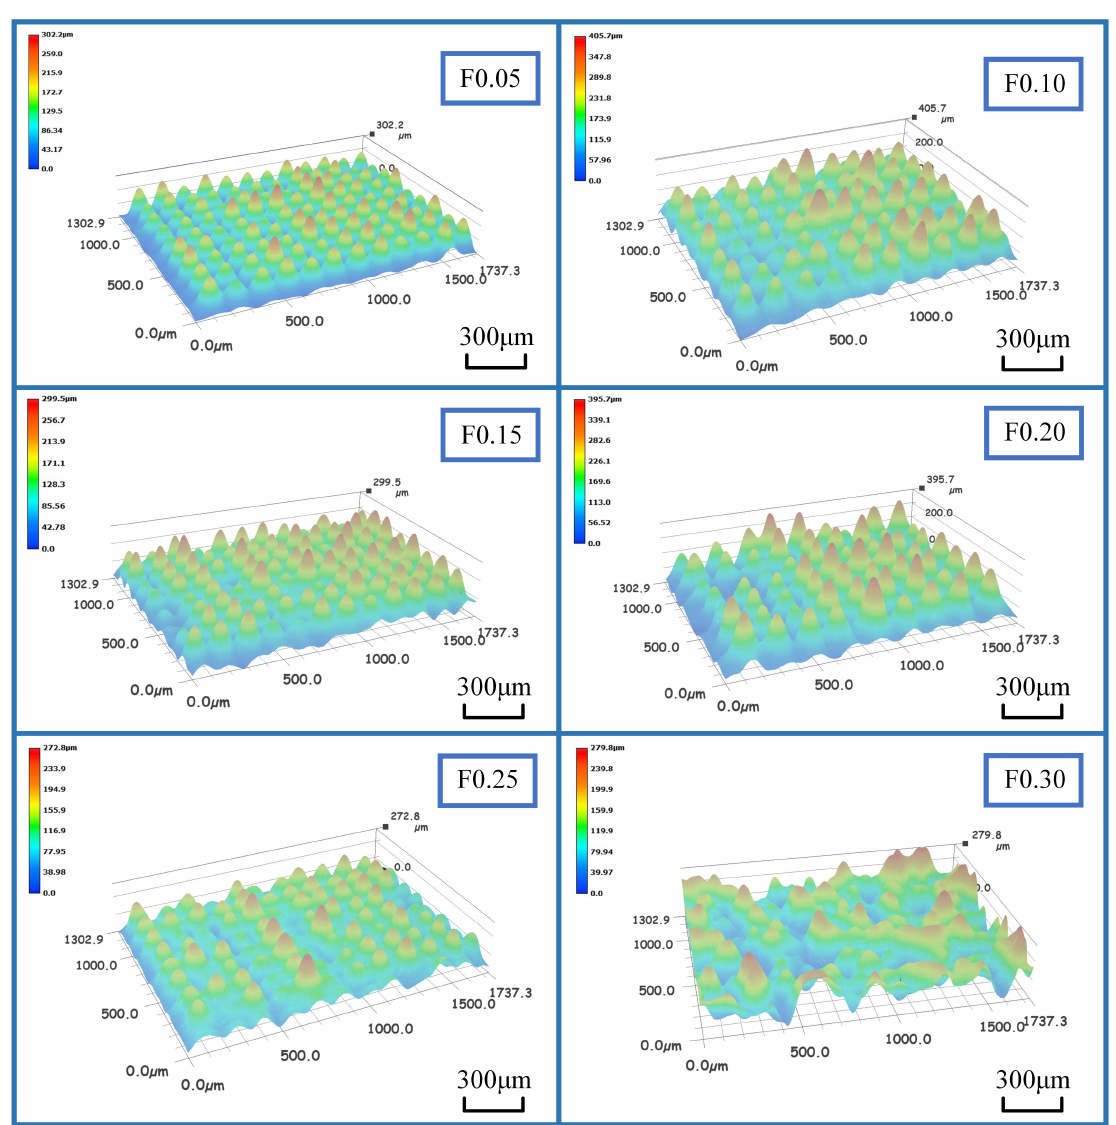
Figure 7. Surface waviness at different feed